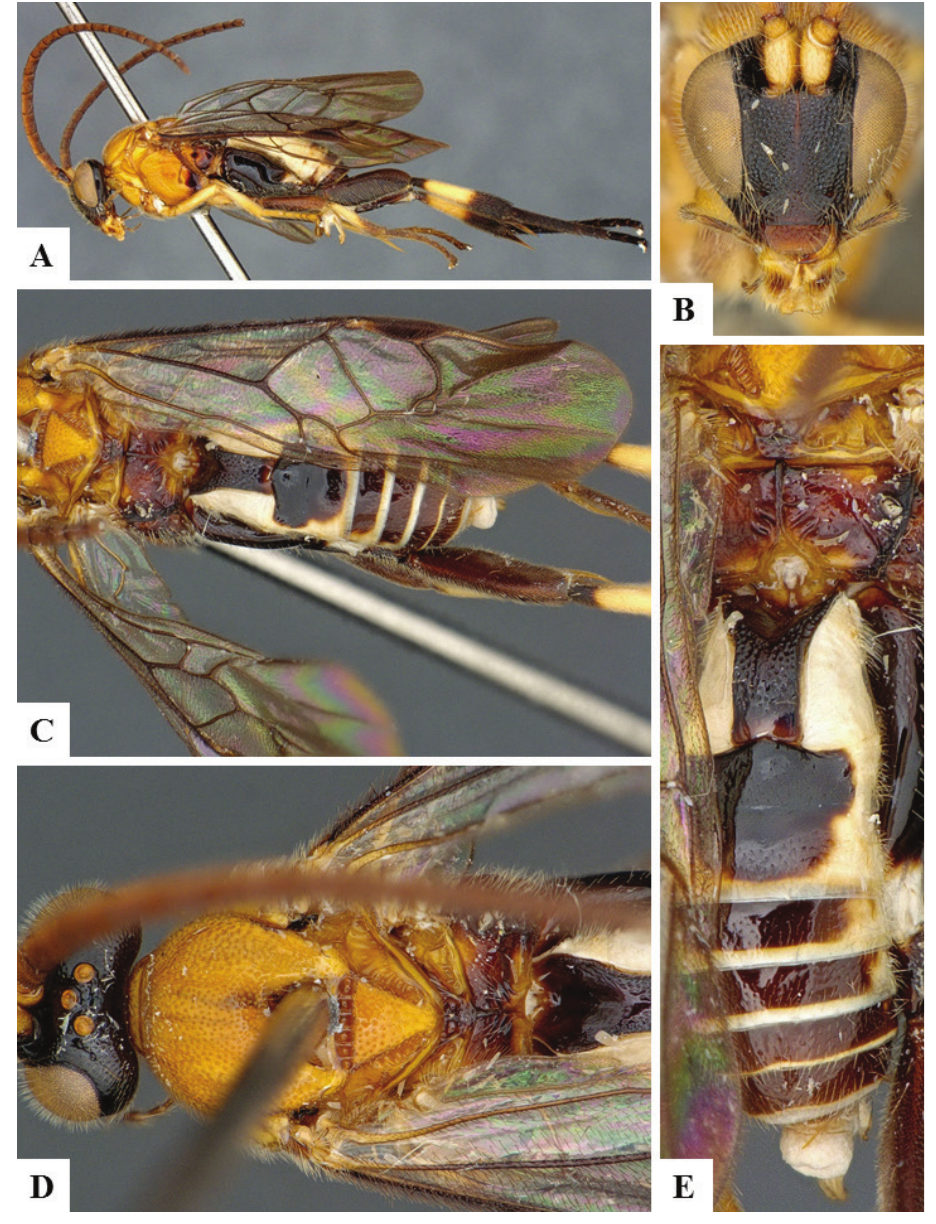
Figure 3. Agupta danyi male paratype CNC497188. A Habitus B Head frontal C Fore wing D Head and mesosoma, dorsal E Propodeum and metasoma,